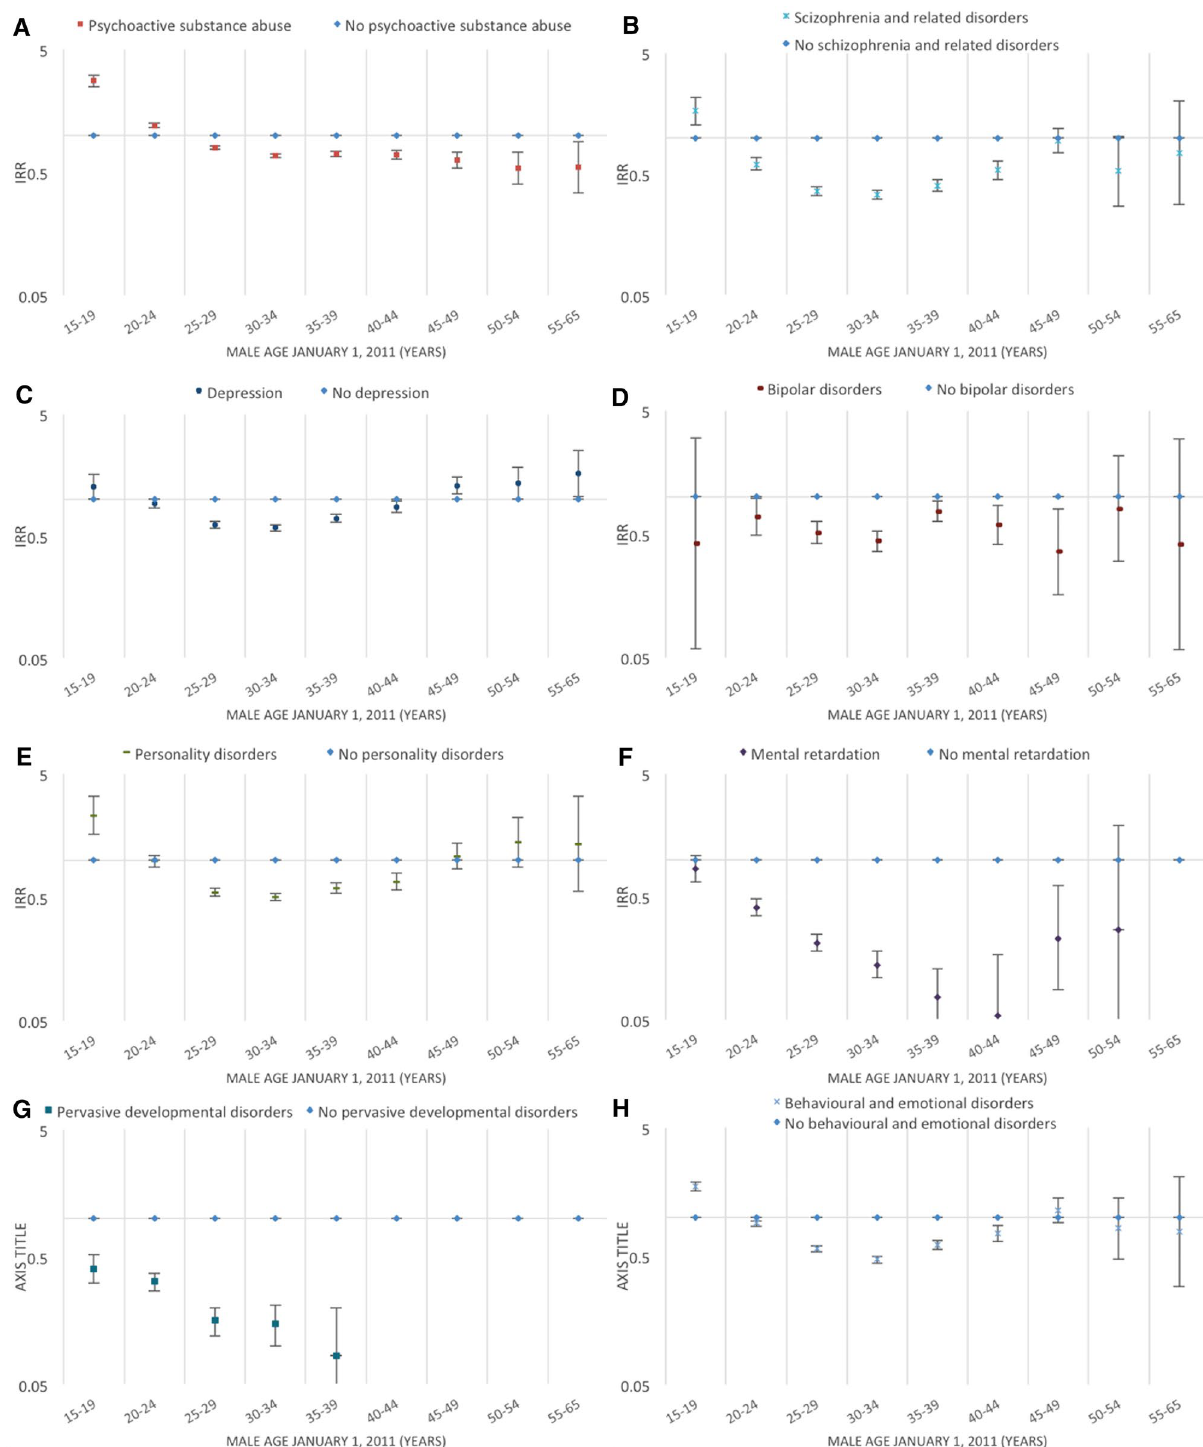
Figure 8. Incidence rate ratios (IRR) of fathering a child according to selected mental illnesses 1 and age 2 . Men aged 15–65 years living in Denmark January 1, 2011 to December 31, 2015. 1 Mental illnesses (diagnosed before January 1, 2011) included: psychoactive substance abuse, schizophrenia and related disorders, depression, bipolar disorders, personality disorders, mental retardation, pervasive developmental disorders, and behavioural and emotional disorders. No men became fathers in the age groups 40–65 years for pervasive developmental disorders or in the age group 55–65 years for mental retardation, thus the IRRs in these age groups are not estimated. 2 Age groups according to the man’s age by January 1,